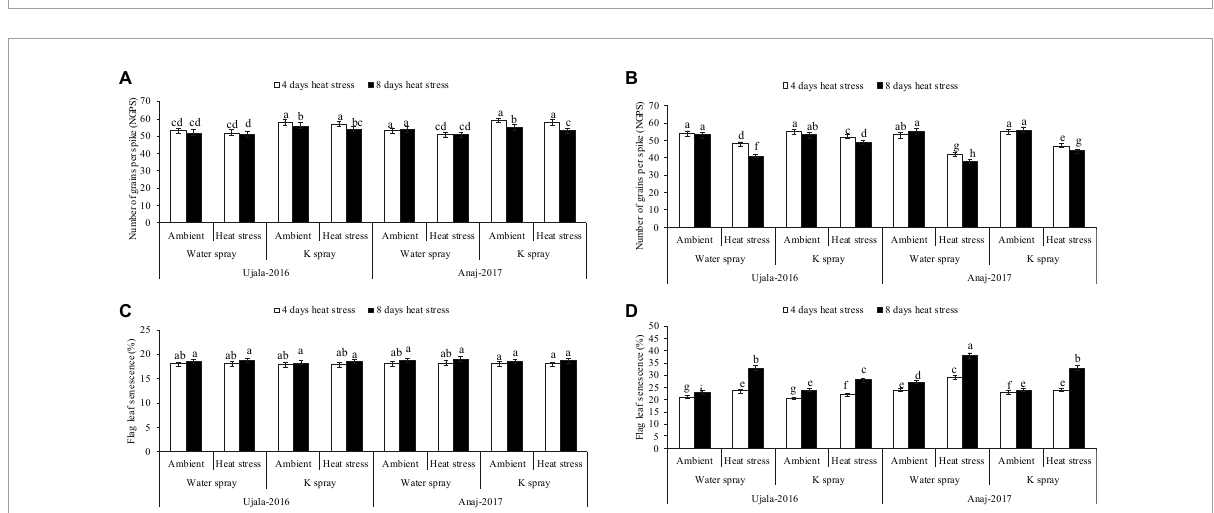
FIGURE3 Impact of optimal, 4 and 8 days of heat stress (1 week after anthesis), potassium (K) spray and cultivars (heat × K × cultivars P < 0.01) on number of grains per spike (A) 2019 (B) 2020 and flag leaf senescence (C) 2019 (D) 2020 of wheat. Values are the means of four replications ( n = 4) ± SE and variants possessing the same letters are not statistically significant at P <